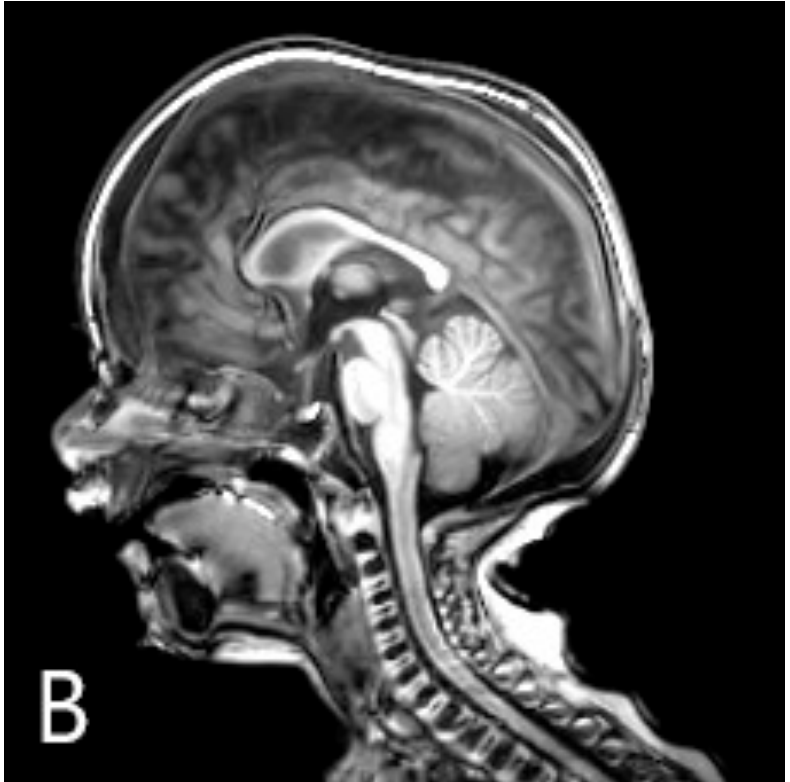
Figure 2. Chest radiography ( A ) shows the disappearance of skeletal malformations 6 months after the transplantation. At this time, sagi tt al T1-weighted MR image ( B ) described the unusual morphology of the calvaria: craniosynostosis.